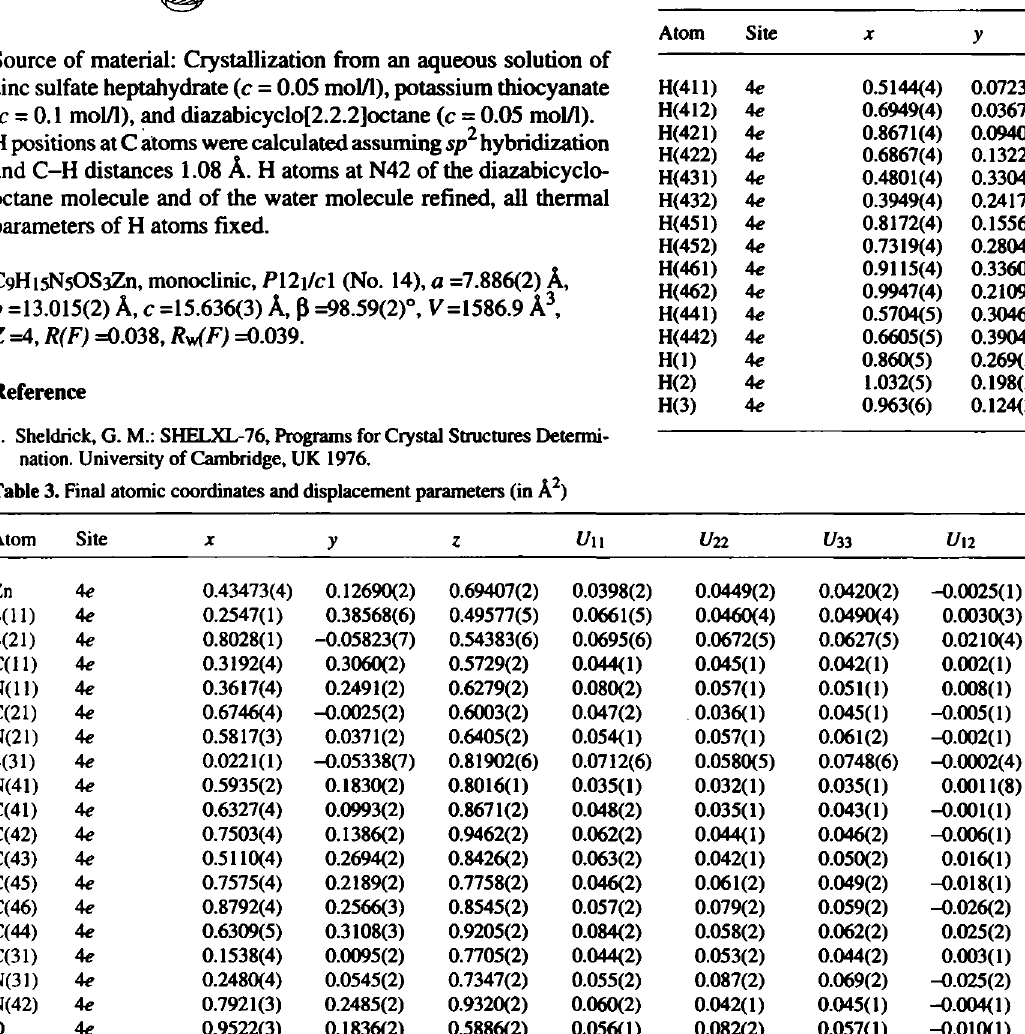
Table 2. Final atomic coordinates and displacement parameters (in Â 2